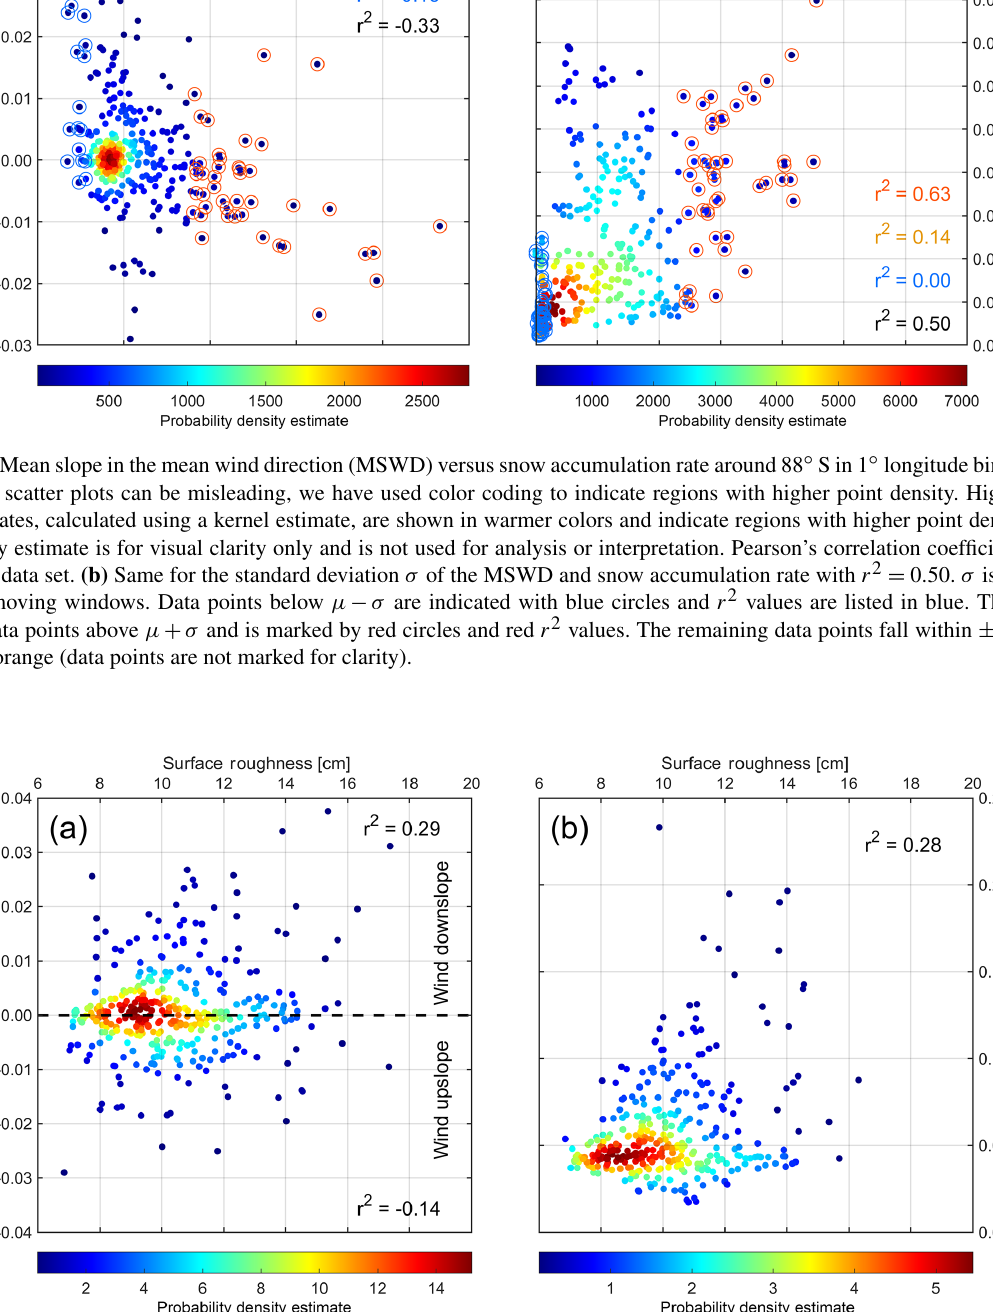
Figure 8. (a) ATM-derived surface roughness versus mean slope in the mean wind direction (MSWD) around 88 ◦ S in 1 ◦ longitude bins (4km). Color indicates the probability density estimate of nearby points using a kernel density estimate. Pearson’s correlation coefficients r 2 are calculated for upslope winds (MSWD < 0) and downslope winds (MSWD > 0). (b) Same for surface roughness versus accumulation